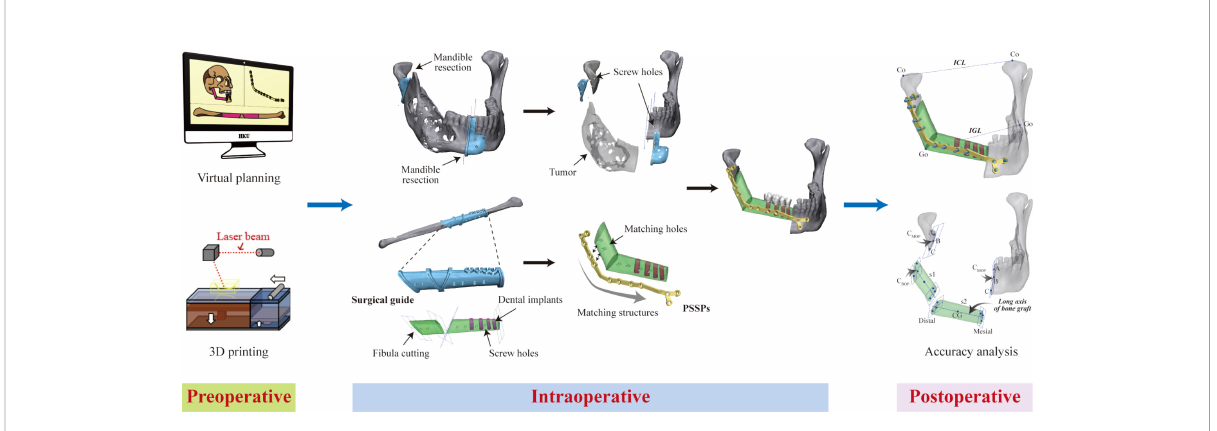
FIGURE 1 Schematic diagram of three phases of computer-assisted jaw reconstruction, including preoperative phase of computer panning and 3D printing, intraoperative phase of precision-enhanced surgery with the use of patient-speci fi c devices, and postoperative phase of feedback of surgical execution by accuracy